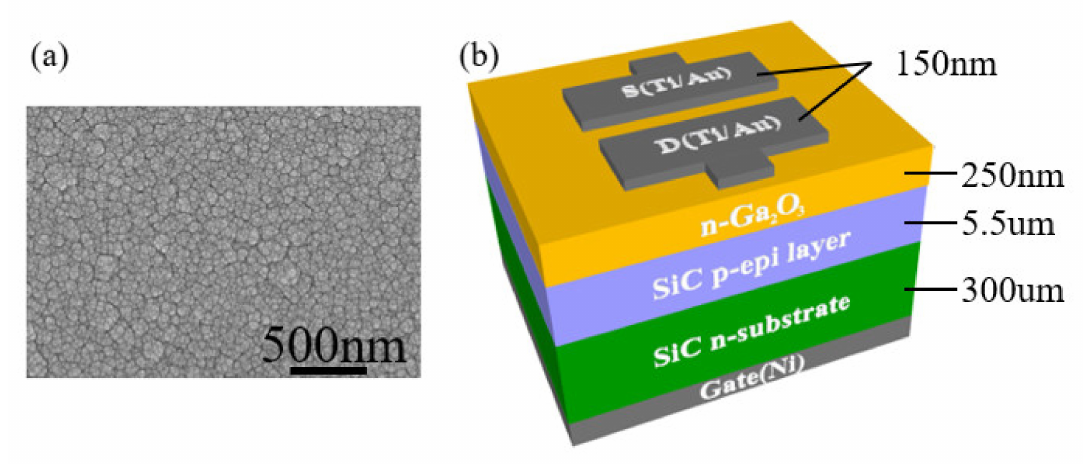
Figure 1. Gallium oxide (Ga 2 O 3 )/4H-silicon carbide (SiC) static induction transistor (SIT) device structure and SEM image. ( a ) SEM data of Ga 2 O 3 , ( b ) SIT device